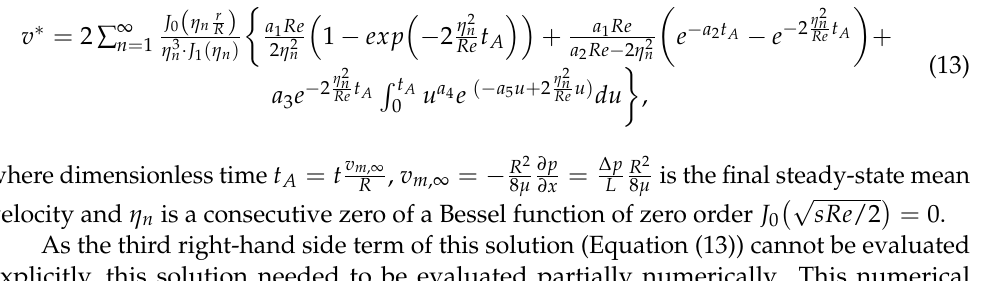
. Figure 5. Exemplary variation of pressure gradient with time R e ≈ 1600. 𝑅𝑅𝑒𝑒 ≈ 1600